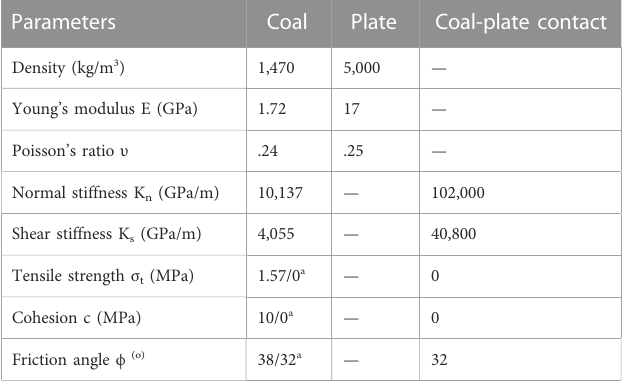
TABLE 1 Mechanical parameters for UDEC-Trigon numerical model.